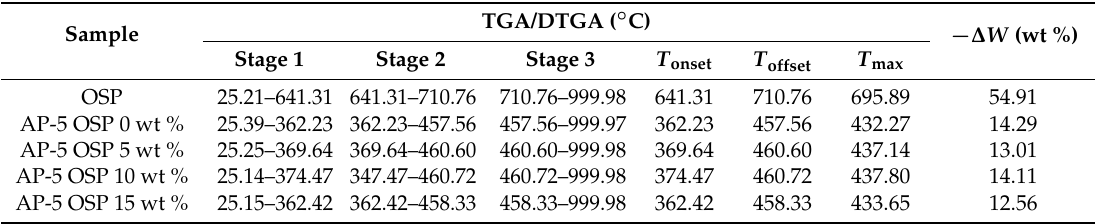
Table 5. TGA and DTGA thermogram data of OSP, neat asphalt, and OSP/asphalt blends containing 5, 10, and 15 wt % OSP loading at heating rate of 10 ◦ C min − 1